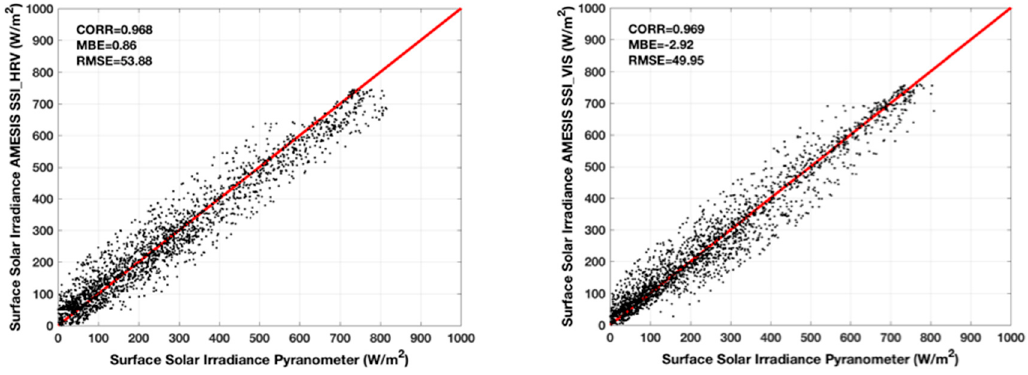
Figure 6. Same as Figure 5, but for cloudy sky. ( Left ): SSI_HRV product, ( right ): SSI_VIS product.